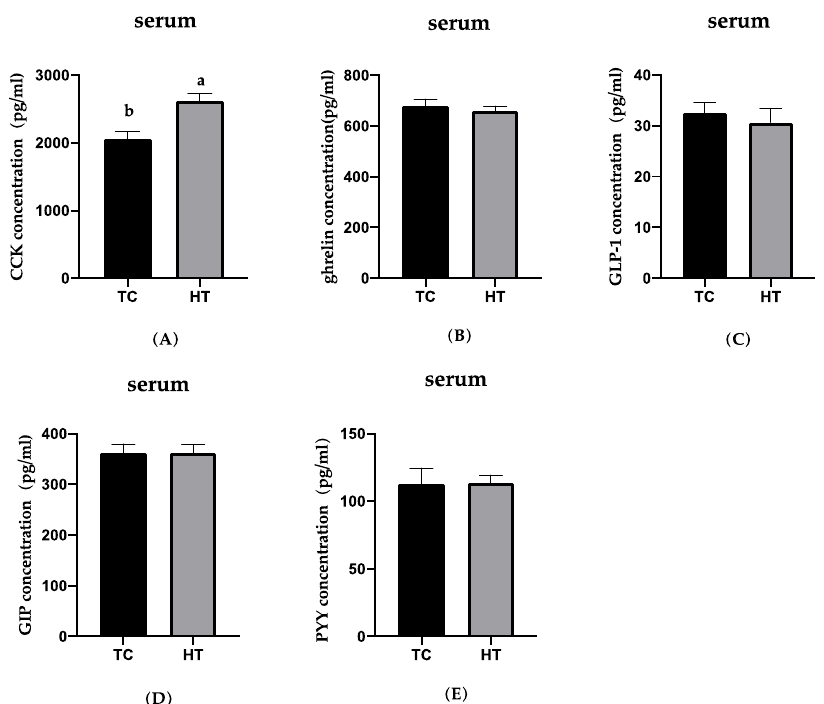
Figure 3. Effects of high temperature on concentration of CCK, ghrelin, GLP-1, GIP and PYY in serum. ( A ), cholecystokinin; ( B ), ghrelin; ( C ), glucagon-like peptide-1; ( D ), glucose-dependent insulinotropic polypeptide; ( E ), peptide YY. a,b Means with different letters within columns indicates significant differences ( p < 0.05).